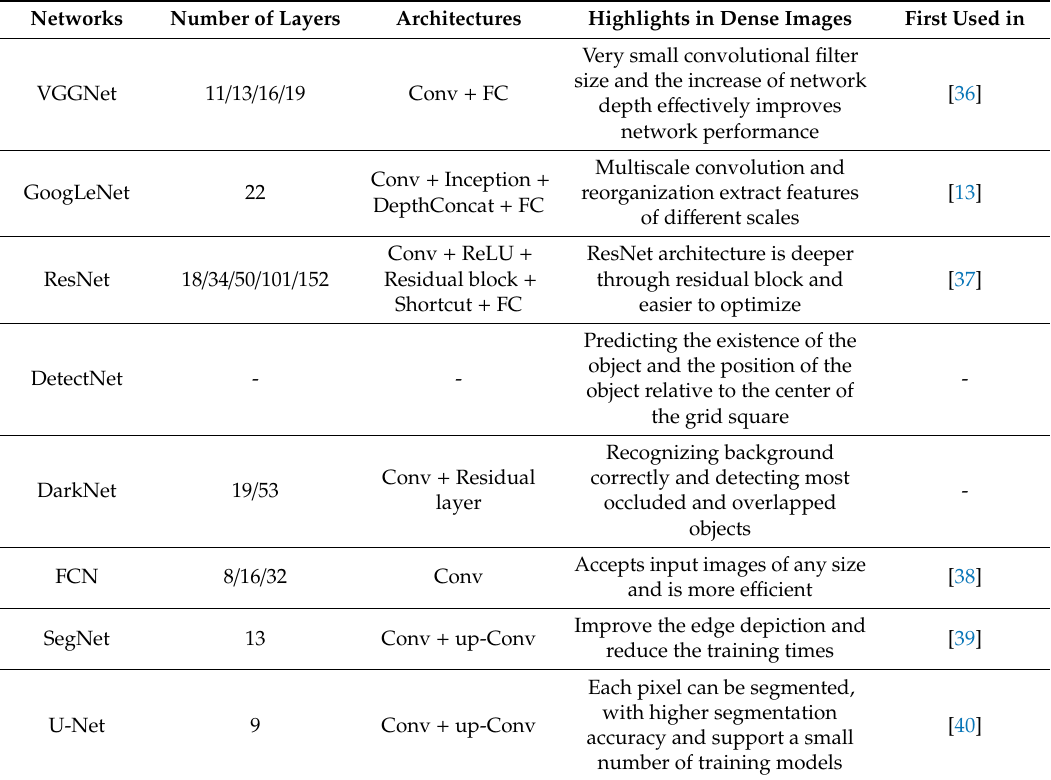
Table 1. Characteristics of various backbone networks in dense images.